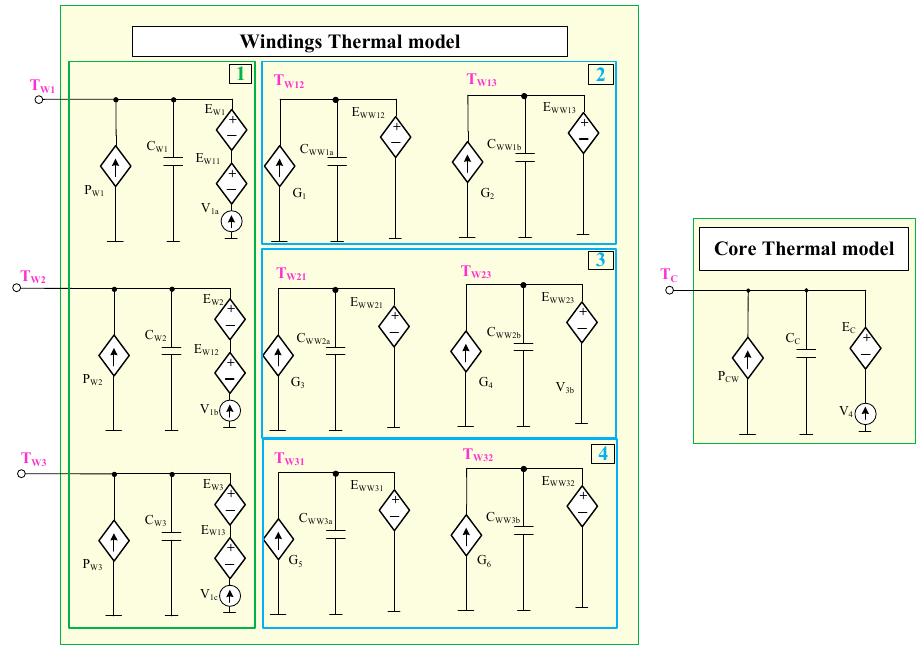
Figure 2. Network representation of the thermal model of a coupled inductor. The controlled voltage sources E W1 , E W2 , and E W3 included in the thermal model of the windings model the nonlinear thermal resistance of individual windings.